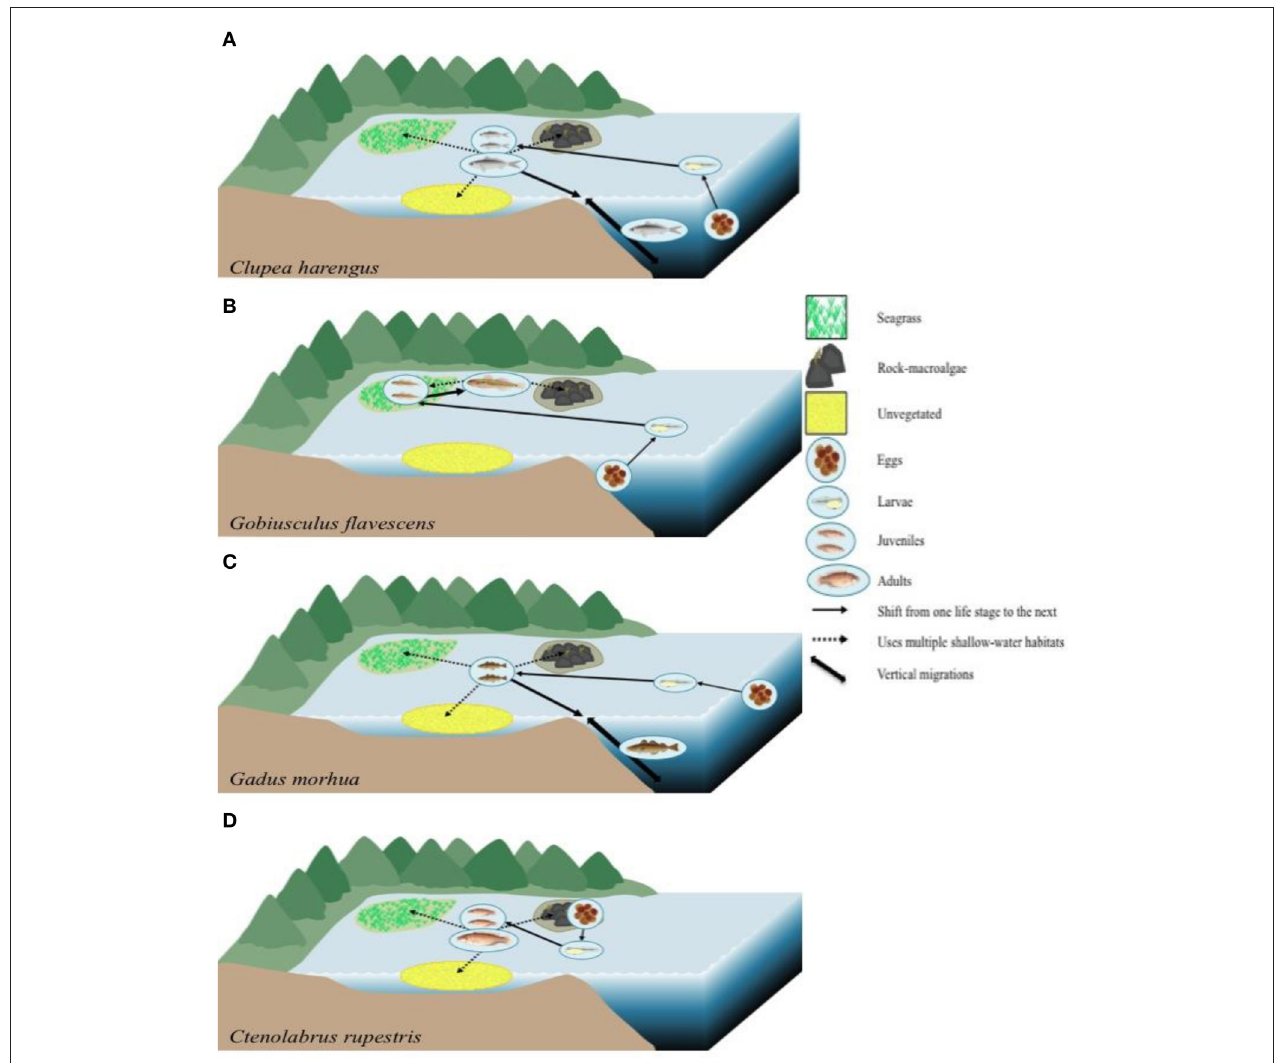
FIGURE 6 | Theoretical diagrams illustrating the habitat connectivity based on ontogenetic migrations of four species found within our study representing the four habitat preference guilds, based on literature as described in the text. (A) Clupea harengus , an occasional shallow-water visitor (OSV) habitat usage. Eggs found in deep water with larvae located in the pelagic zone (Reid et al., 1999; Petitgas et al., 2013). Juveniles and adults in large schools utilizing coastal waters and the open ocean (Reid et al., 1999). (B) Stationary species (SS) Gobiusculus flavescens ; adults linked to seagrass and rock-macroalgae areas (Folkestad, 2005; Froese and Pauly, 2015), juveniles in seagrass habitats (Staveley et al., 2017), eggs demersal and larvae in the sublittoral zone (Folkestad, 2005). (C) Juvenile migrant (JM) Gadus morhua ; adults perform vertical migrations, juveniles utilize multiple shallow-water habitats (Staveley et al., unpublished data; Wennhage and Pihl, 2002), and larvae and eggs are in the pelagic zone (Petitgas et al., 2013). (D) Shallow-water generalist (SWG) Ctenolabrus rupestris . Juveniles and adults are associated with seagrass and rock-macroalgae (Pihl and Wennhage, 2002; Staveley et al., 2017), eggs are laid in the rock-macroalgae habitats (Darwall et al., 1992) and larvae in the pelagic zone (Kullander et al., 2012). Fish illustrations of G. flavescens and C. rupestris by Maj Persson. Other symbols courtesy of the Integration and Application Network